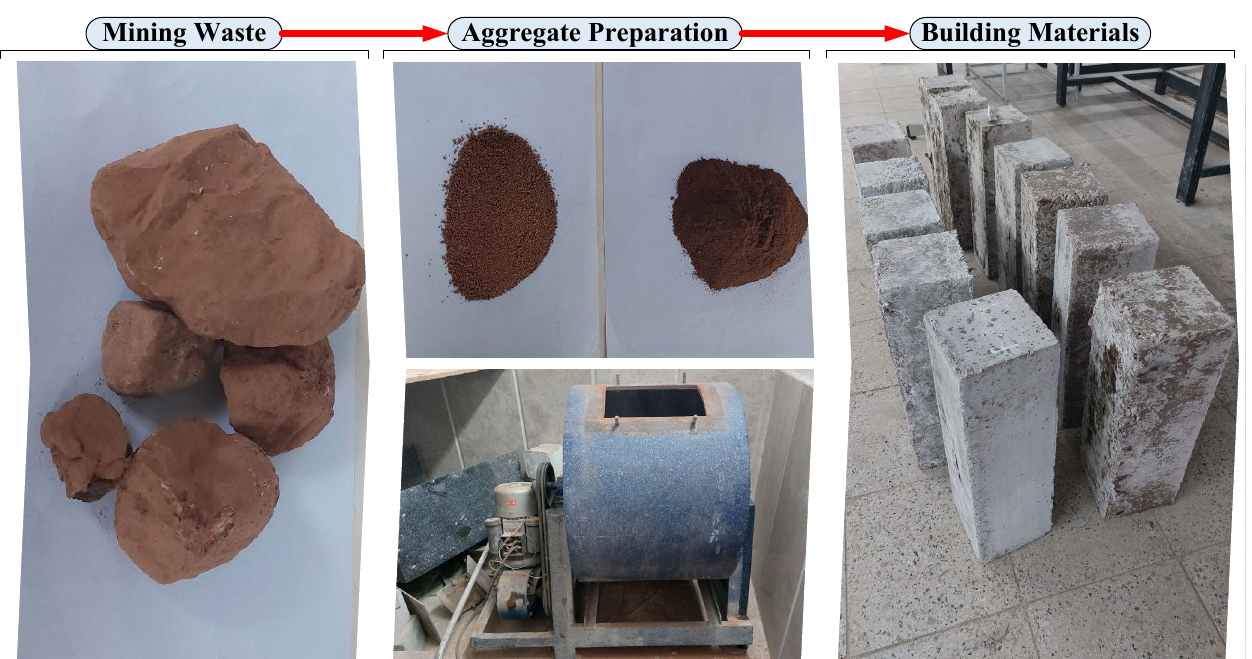
Figure 2. The process of utilizing mining waste as building materials.